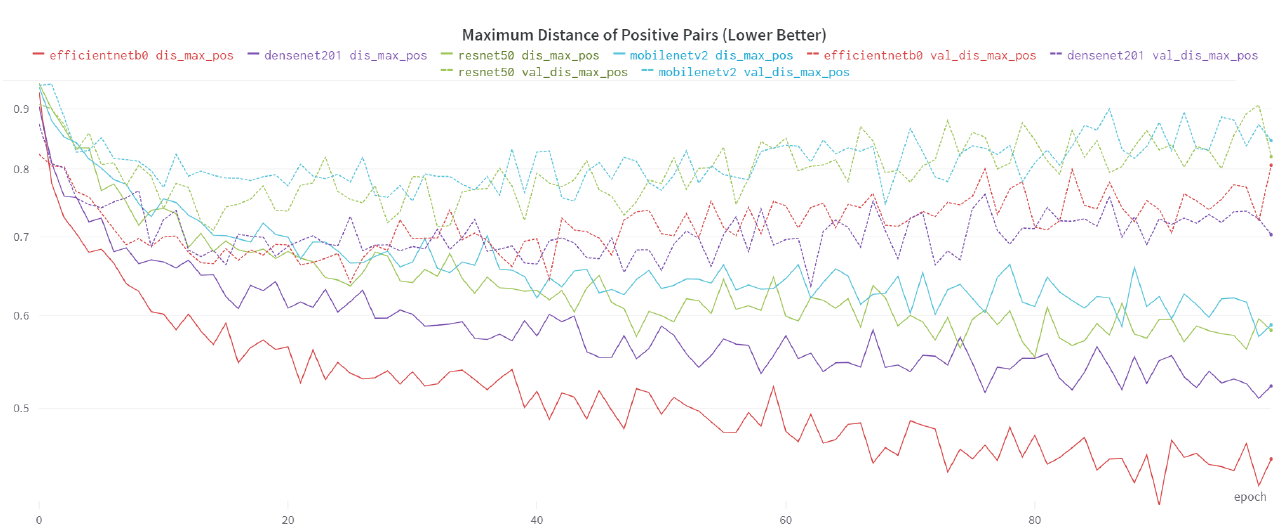
Figure 11. The comparison of the minimum distance of negative pairs among ResNet50, DenseNet, MobileNetV2, and